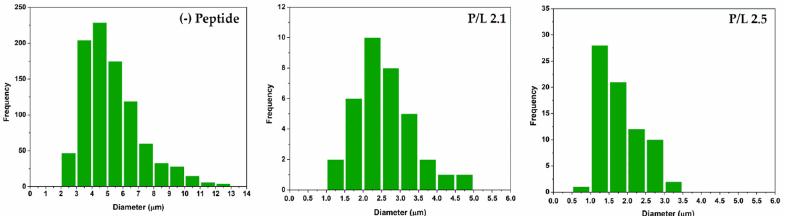
Figure 10. Size diameter distribution of the POPC:POPG (1:1) GUVs and the new lipid aggregates formed at high P/L ratios. The size diameter of the GUVs in the absence ( − ) and presence of peptide (P/L ratio of 2.1 and 2.5) was measured in ImageJ software using 4 − 5 images per condition, and a number of vesicles per image of 134–270 (absence of peptide; 920 total), 3–16 (2.1 P/L; 35 total), and 10–20 (2.5 P/L; 74 total).